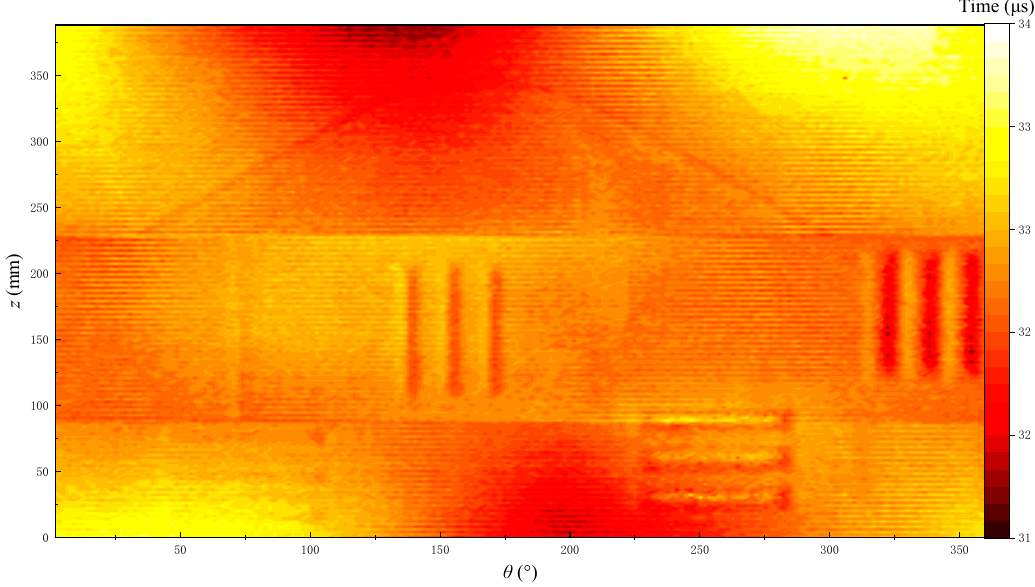
Figure 24. Echo arrival time imaging for the simulated borehole. The amplitudes are extracted via the peak-to-peak method, normalized and then imaged. The 2D echo amplitude imaging is shown in Figure 25. The P in the figure represents the normalized sound pressure amplitude, which is dimensionless. The echo amplitude decreases at the positions of the fractures and holes in the simulated borehole, thereby visualizing the position of the fractures on the echo amplitude imaging. When the fracture width is smaller than the acoustic spot diameter of the ultrasonic transducer (8 mm), the echo amplitude at the fracture position exhibits less reduction. In Figure 25, the echo amplitude of the oblique fracture (5 mm wide) and the hole decreases to about 0.7 times that at the position without fractures (the black dashed line in Figure 25). When the fracture width is greater than or equal to the acoustic spot diameter of the ultrasonic transducer, the echo amplitude at the fracture position decreases remarkably. The larger the fracture width, the greater the amplitude decrease. For example, the amplitude of vertical and horizontal fractures in Figure 25 decreases to within 0.5 times the maximum value (the black dotted line in Figure 25).